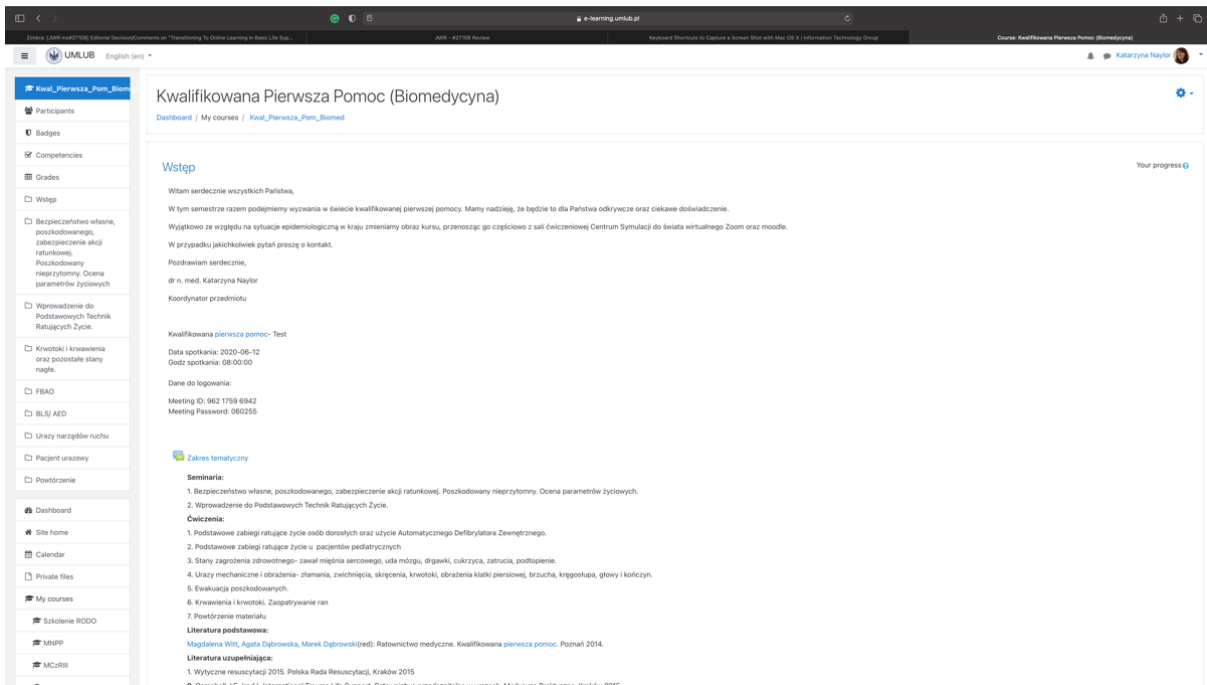
Figure 2. A general overview of an introductory Moodle course website.